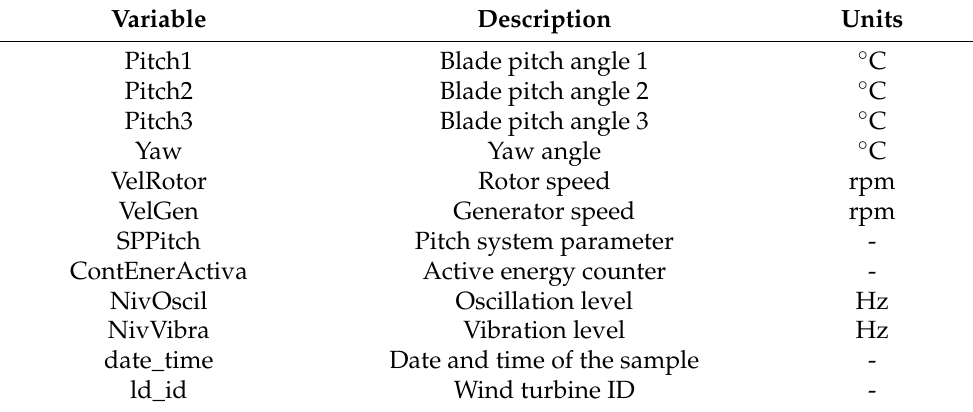
Table 6. Control